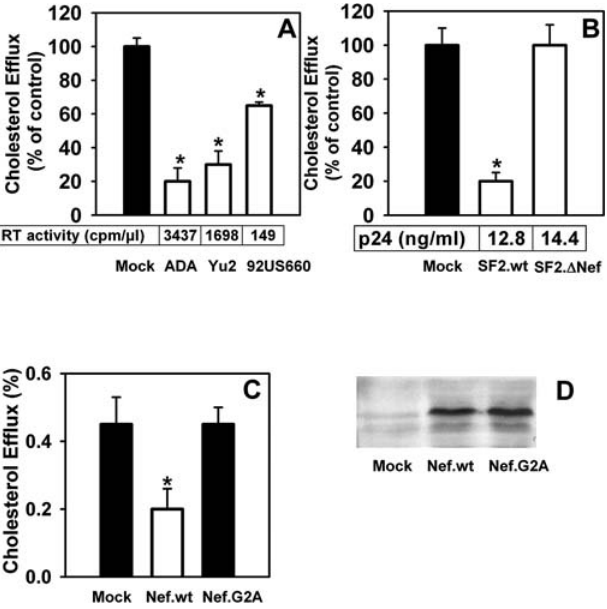
Figure 1. HIV-1 Nef Impairs Cholesterol Efflux from Macrophages (A) Monocyte-derived macrophages were inoculated with indicated HIV- 1 strains equalized according to RT activity and cultivated for 21 d (RT activity in the culture supernatants on day 21 is shown beneath the bars). Mock-infected cells were incubated with virus-free medium. Specific cholesterol efflux to apoA-I (30 l g/ml) was performed for 12 h and analyzed as described in Materials and Methods. Results are presented as percentage of efflux from mock-infected cells (taken as 100%) and are mean 6 standard deviation (SD) of triplicate determinations. An asterisk (*) indicates p , 0.001 (B) Monocyte-derived macrophages were inoculated with VSV-G- pseudotyped HIV-1 SF2 either deficient in Nef (SF2. D Nef) or carrying WT Nef (SF2.wt). Specific cholesterol efflux to apoA-I (30 l g/ml) was analyzed on day 6 after inoculation using the same procedure as described in (A). p24 concentration in the culture medium is shown beneath the bars. Results are presented as percentage of efflux from mock-infected cells (taken as 100%) and are mean 6 SD of triplicate determinations. An asterisk (*) indicates p , 0.001. (C) RAW 264.7 cells were transfected with plasmids expressing indicated Nef variants or an empty vector (mock-transfection). Twenty-four hours after transfection, LXR agonist, TO-901317 (1 l mol/L), was added. Cholesterol efflux to apoA-I (30 l g/ml) was performed for 3 h with cells 48 h after transfection as described in Materials and Methods. Means 6 SD of quadruplicate determinations are shown. An asterisk (*) indicates p , 0.001. (D) Immunoblotting of RAW 264.7 cells transfected with empty vector (mock), WT Nef derived from HIV-1 strain SF2 (Nef.wt), or Nef.G2A mutant, and stained with anti-Nef antibodies. DOI: